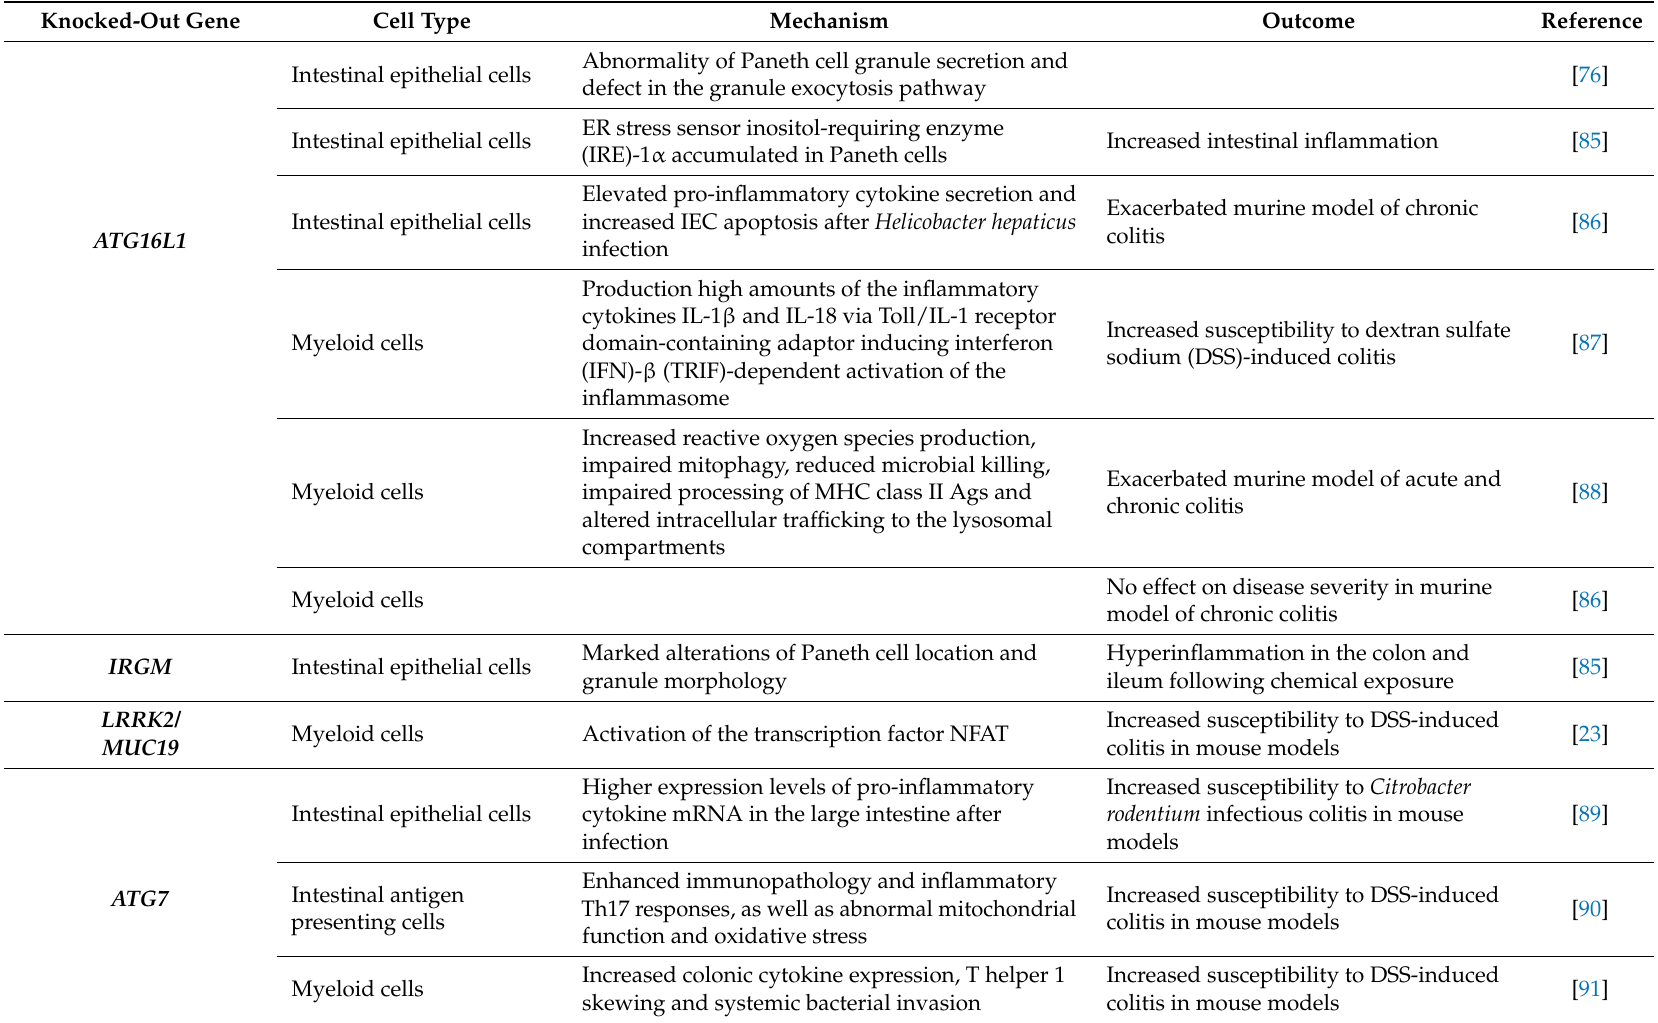
Table 1. Genetic models related to autophagy in intestinal